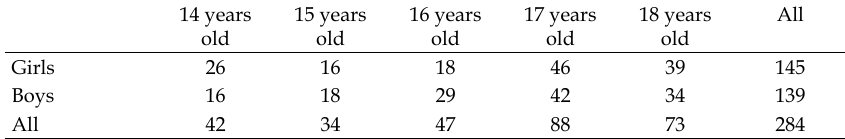
Table 1. Distribution of the Respondents by Sex and